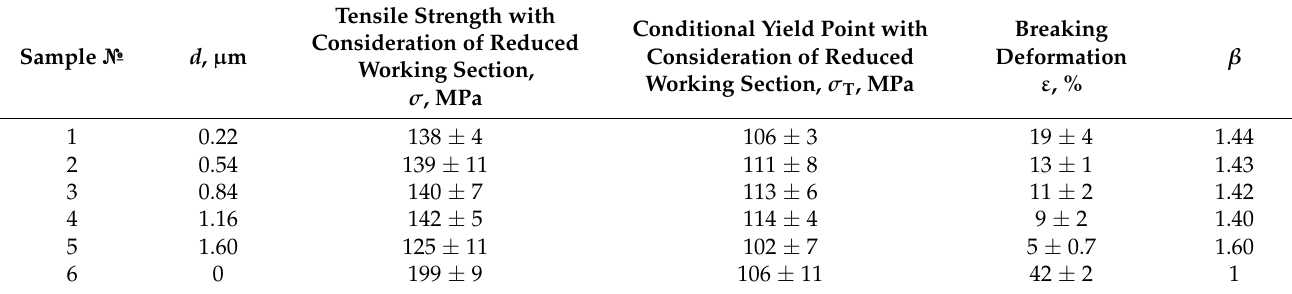
Table 3. Tensile strength and mechanical characteristics of tested TM.